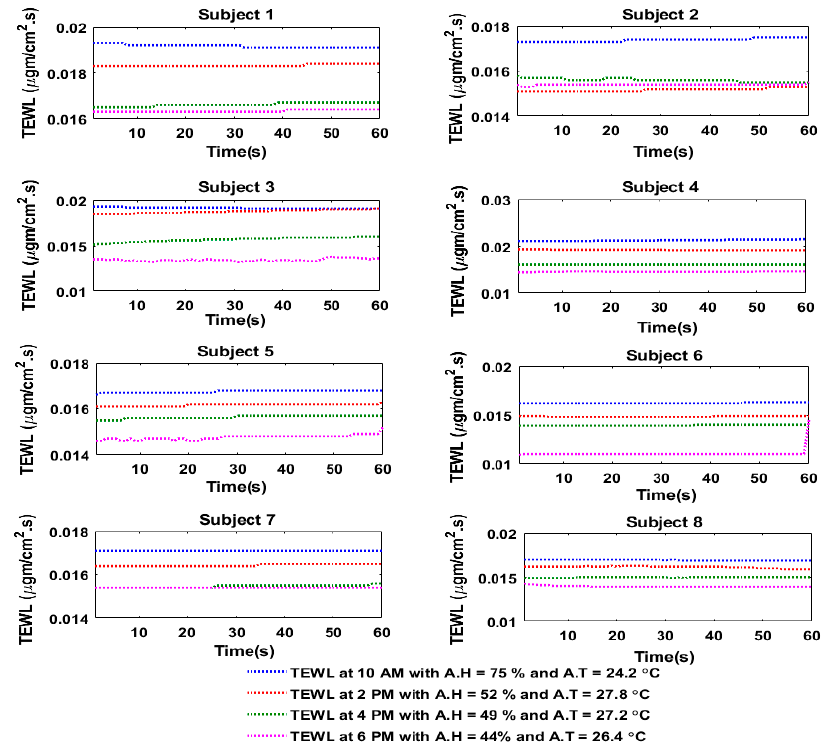
Figure 7. TEWL of the eight subjects at different times of the day during the indoor experiment.